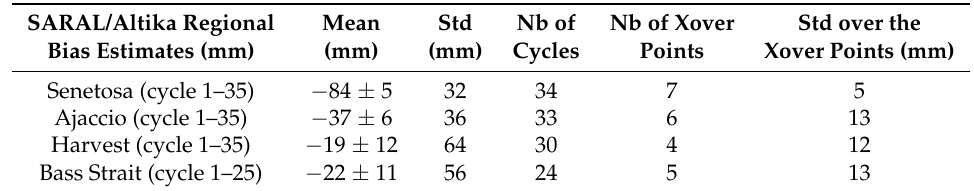
Figure 10. Altimeter crossover points used for the SARAL/AltiKa regional bias estimate in Corsica ( a : Ajaccio in blue, Senetosa in orange), Harvest ( b : green dots) and Bass Strait ( c : green dots). The SARAL/AltiKa and Jason-2 grounds tracks are shown respectively in yellow and red. Table 1. SARAL/AltiKa regional bias estimates at each site. In Bass Strait, the in situ data available for this study only covers the period until cycle